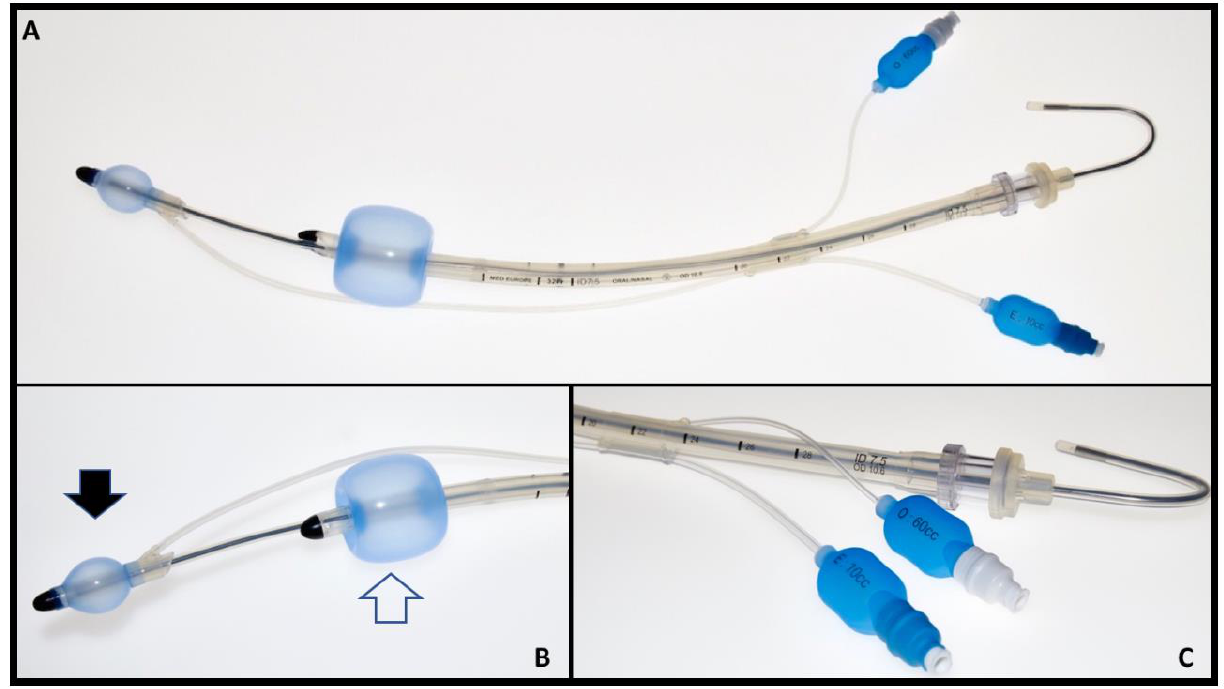
Figure 2. Spritztube characteristics ( A ): device assembled for positioning; note the stylet inside. ( B ): details of distal (oesophageal) cuff (solid arrow) and oropharyngeal cuff (empty arrow). ( C ): colour-coded pilot balloons for oesophageal and oropharyngeal cuffs with respective (10 and 60 cc) inflation volumes.